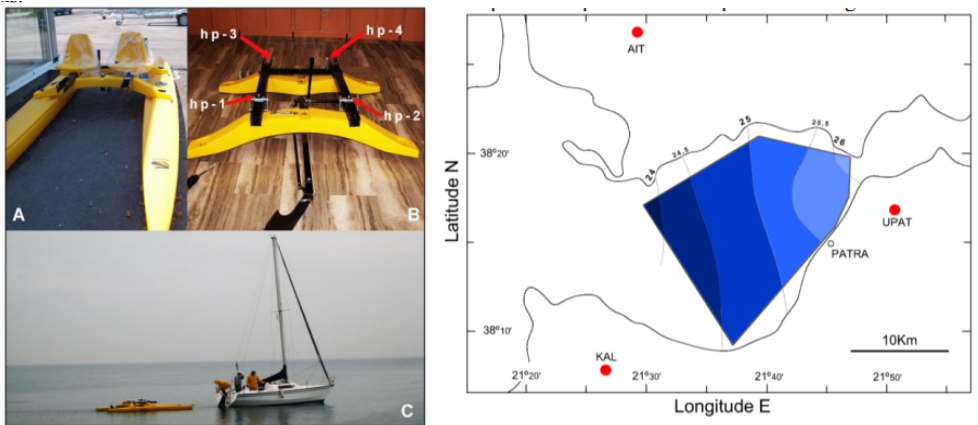
Figure 13. (Left) Catamaran platform ( A ) with four GNSS receivers ( B ) in the Gulf of Patras ( C ). (Right) Patras gulf SST in meters in reference to the WGS 84 ellipsoid [17].